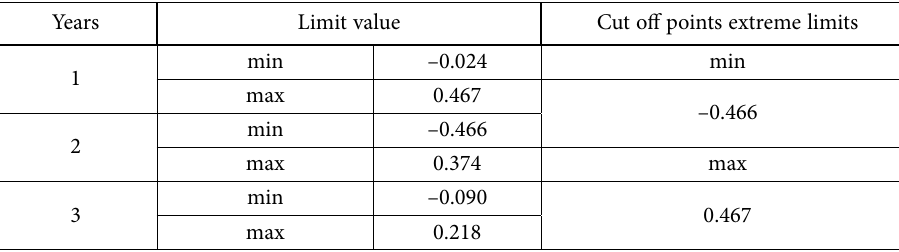
Table 8. Misclassification limits (source: authors’